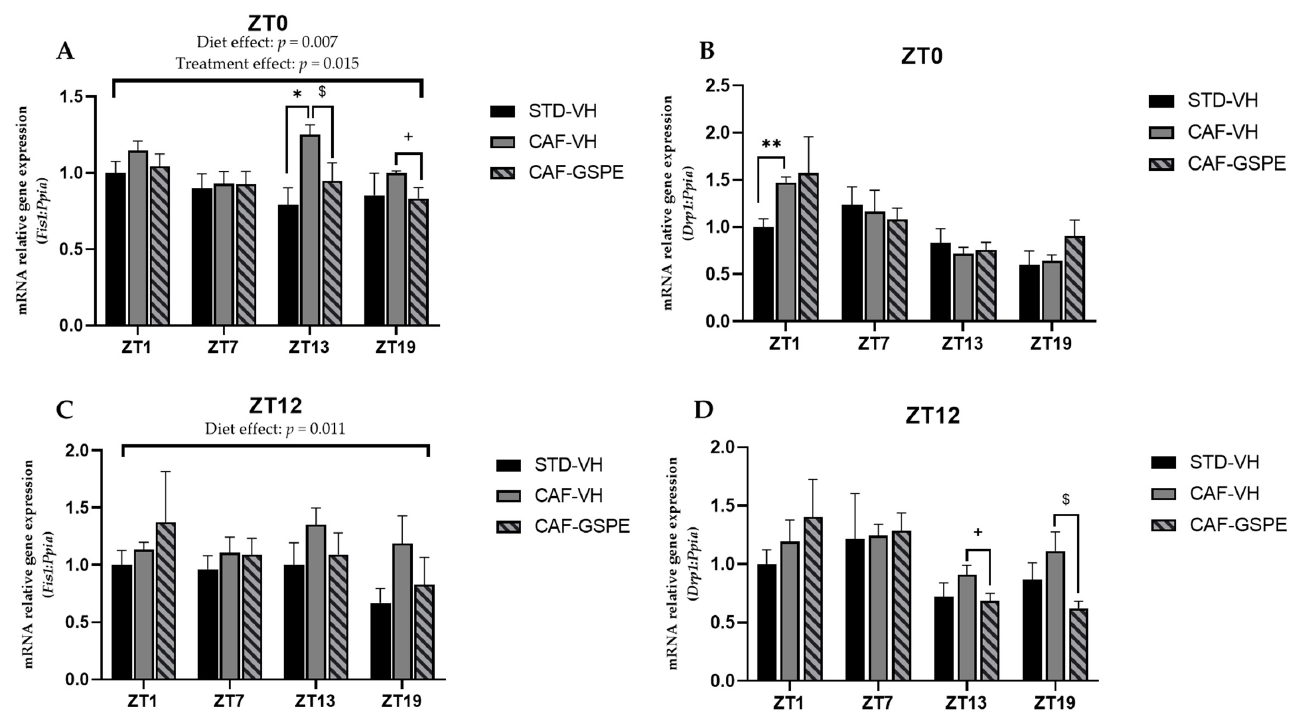
Figure 5. Relative gene expression of mitochondrial fission genes in the liver. Rats were fed an STD or CAF diet and received a daily dosage of vehicle or GSPE in the morning (ZT0) ( A , B ) or at night (ZT12) ( C , D ). After 9, weeks the rats were sacrificed at 9 a.m. (ZT1), 3 p.m. (ZT7), 9 p.m. (ZT13) or 3 a.m. (ZT19), and mRNA levels of Fis1 and Drp1 were determined. The values are the mean ± SEM ( n = 4). * The effect of diet within vehicle groups (Student’s t test or DMS post hoc test, * p ≤ 0.05, ** p ≤ 0.01); $ the effect of GSPE consumption within CAF groups (Student’s t test or DMS post hoc test, p < 0.05; + indicates tendency between CAF-VH and CAF-GSPE using Student’s t test ( p = 0.1–0.051).